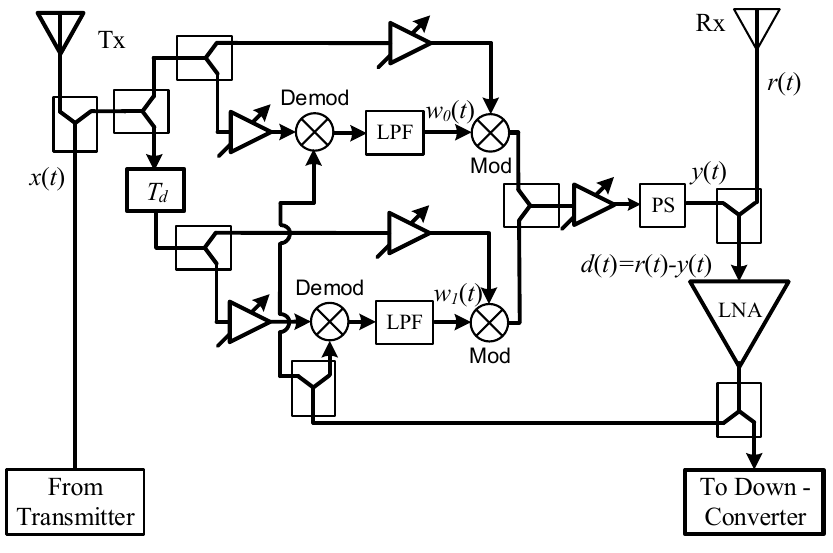
Figure 4. A practical structure of the ALMS loop.